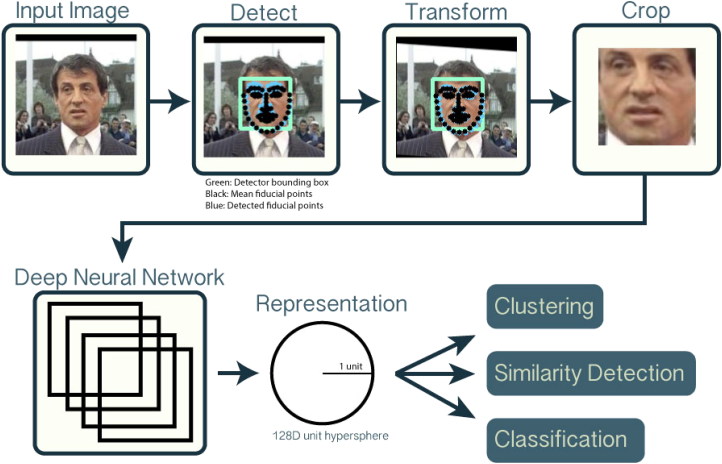
An example of the OpenFace procedure ADDIN.